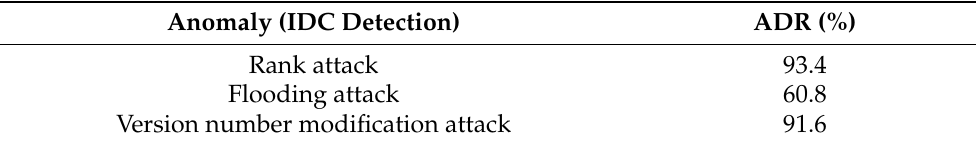
Table 3. Anomaly detection rates for different attacks.